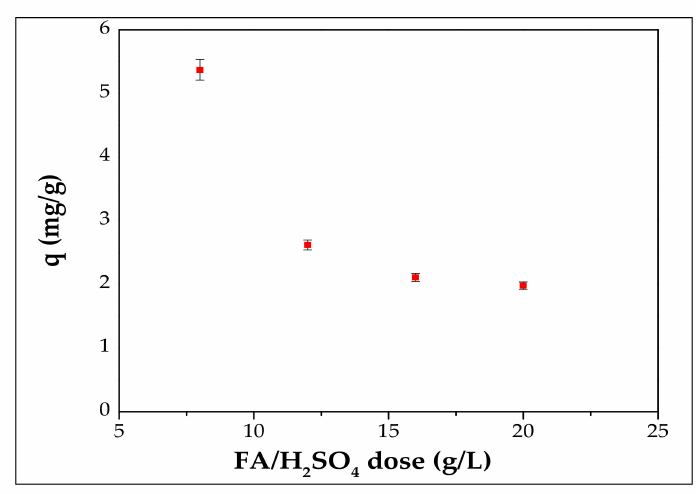
Figure 6. E ff ect of FA / H 2 SO 4 dose in Cd 2 + adsorption.